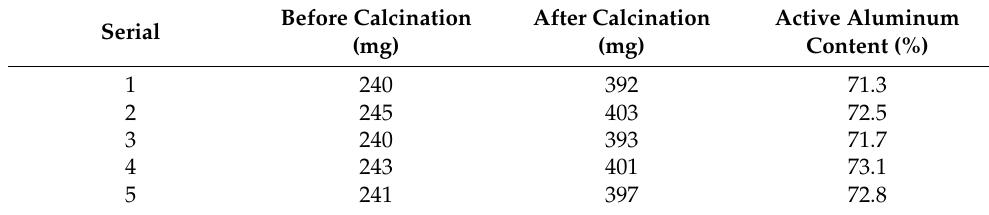
Table 1. Results of activity measurement of Al NPs.